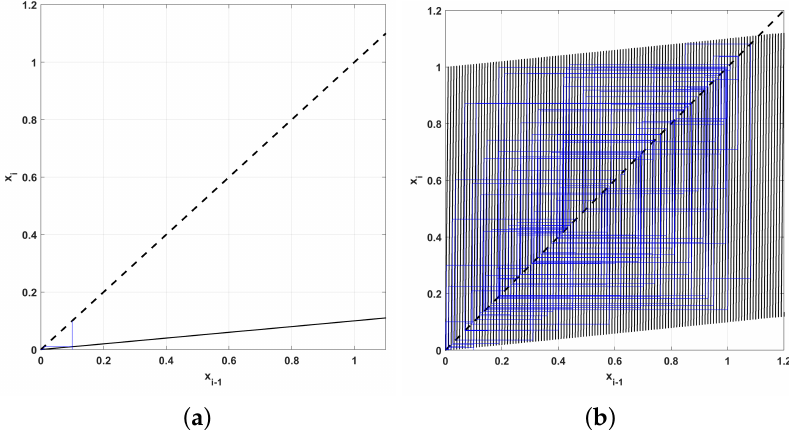
Figure 5. Cobweb diagrams for ( a ) the linear map (22) and ( b ) modified map (23), for k = 10, a = 100, N =